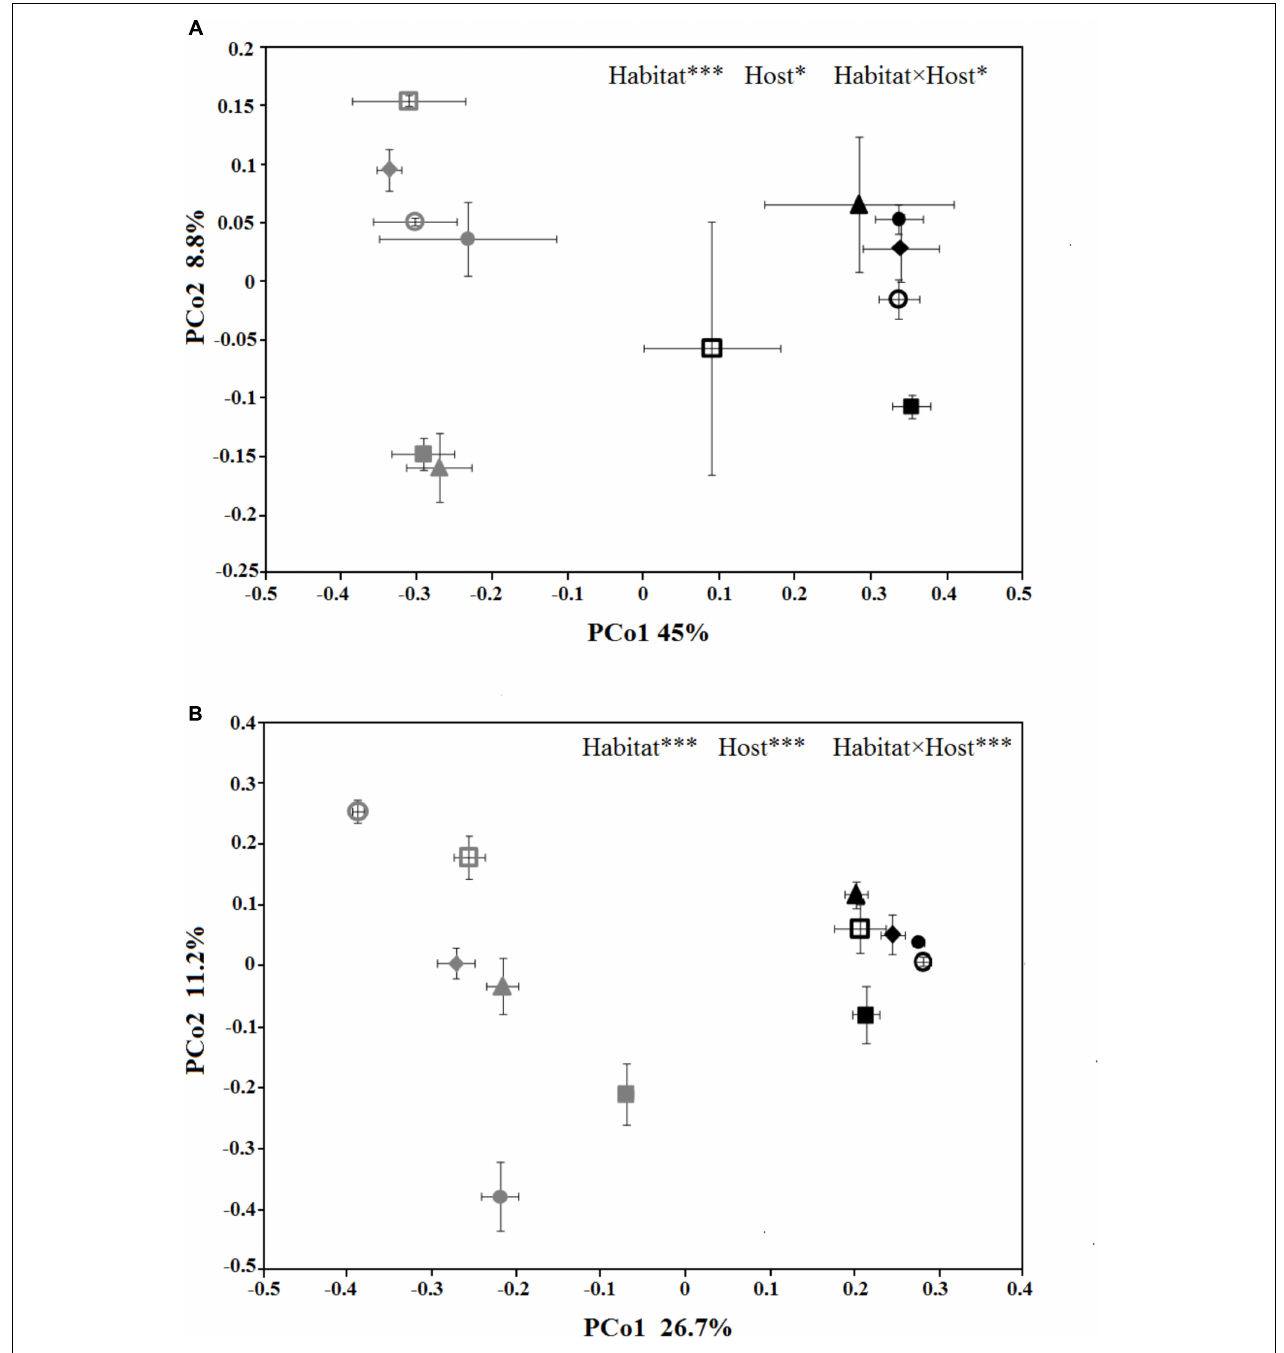
FIGURE 3 | Principal coordinates analysis (PCoA) ordination of the bacterial/archaeal (A) and the fungal (B) communities, associated to the six spruce species phyllosphere and near-root soil. The values are means of three replicate samples plus SE for each host type. The symbols are as follows: triangles = PL; solid squares = PS; solid circles = PA; empty circles = PC; empty squares = PK; and diamonds = PW. The full name of each plant species is reported into the text. The symbols color-gray and black, indicate microbial communities in phyllosphere and soil, respectively. The results of relationships between microbial community structure and host species identity in the PERMANOVA are given in the higher right of each panel: ∗ p < 0.05; ∗∗ p < 0.01; ∗∗∗ p < 0.001.